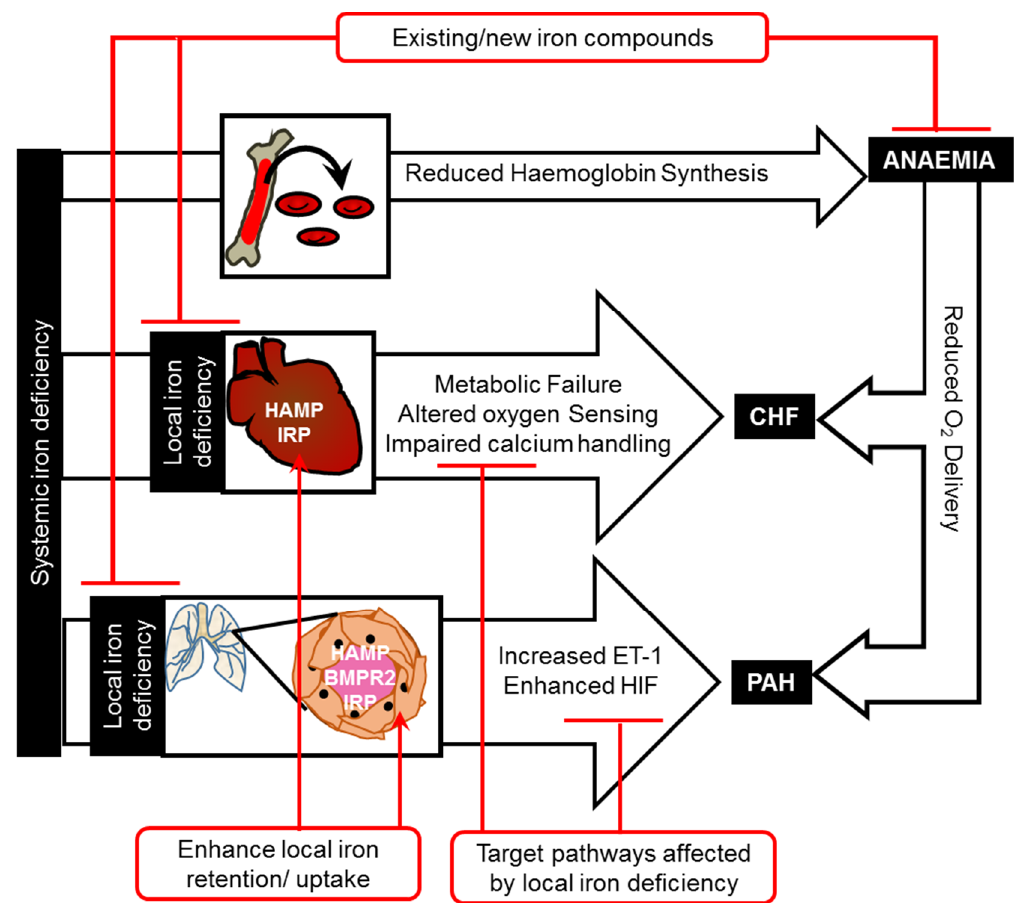
Figure 1. Mechanisms linking iron deficiency and cardiovascular disease.